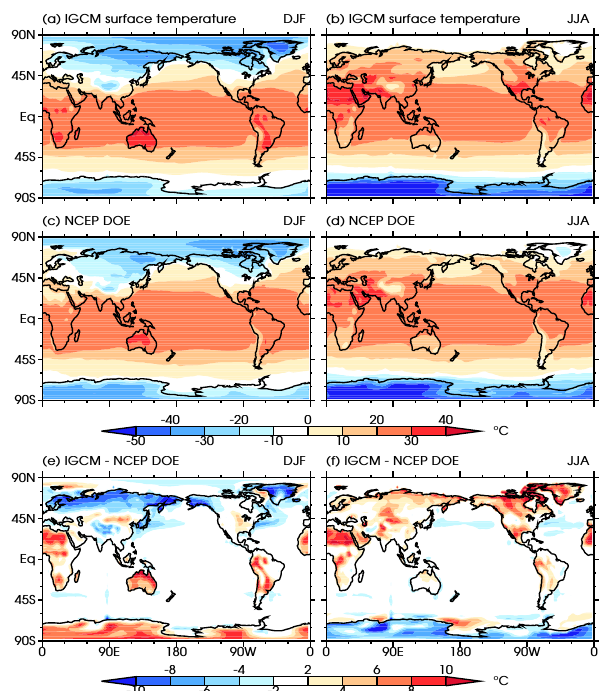
Figure 3. Surface temperature ( ◦ C) in IGCM4 (a, b) , NCEP-DOE reanalysis (c, d) and difference between IGCM4 and reanalysis (e, f) . In all cases the left-hand panels display results for the DJF sea- son, and the right-hand panels display results for JJA season. For the reanalysis a mean over the years 1979–2013 is